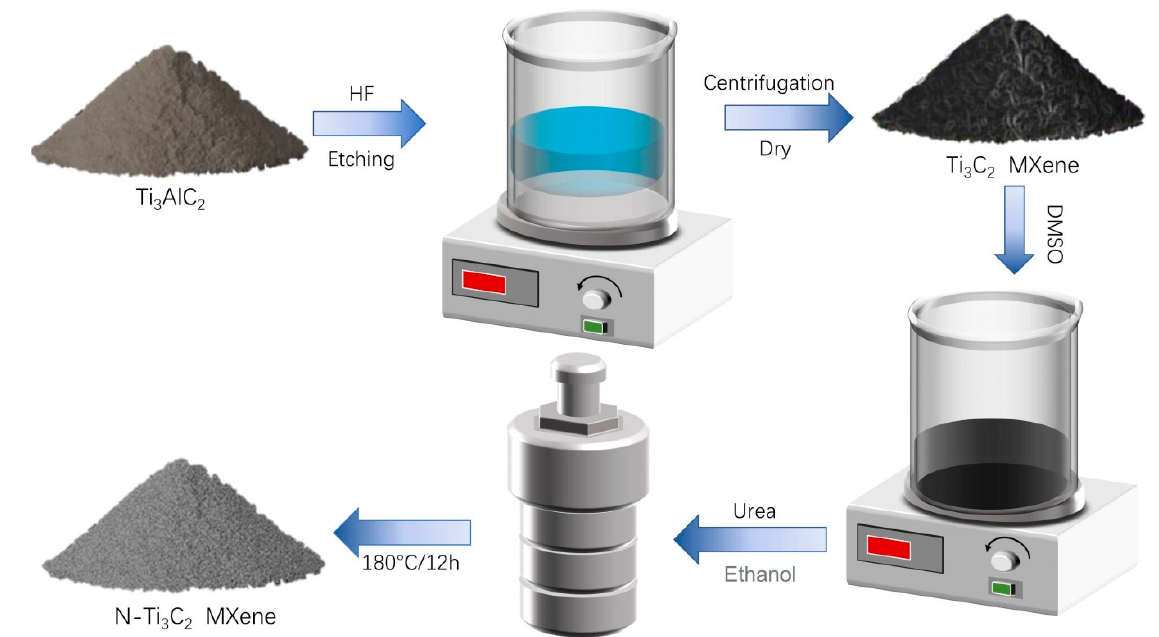
Figure 1. Roadmap for the synthesis of N − Ti 3 C 2 catalyst.